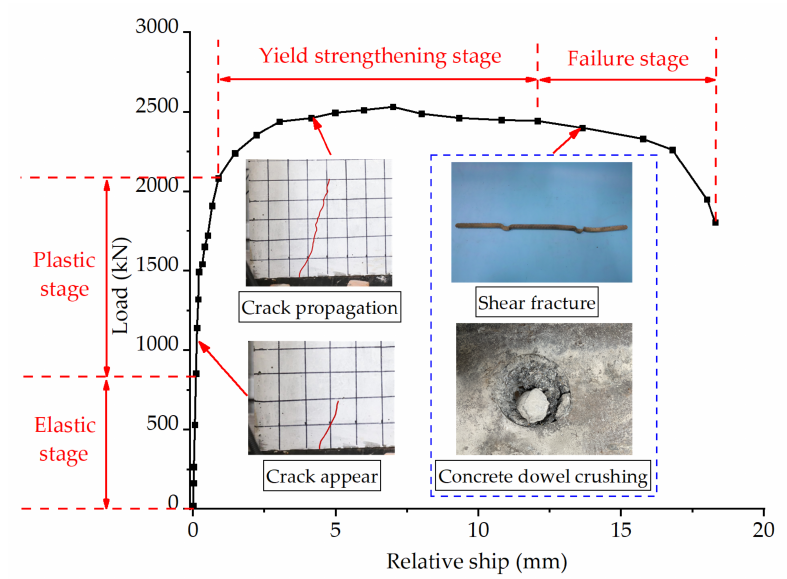
Figure 5. Typical load-slip curve from Specimen